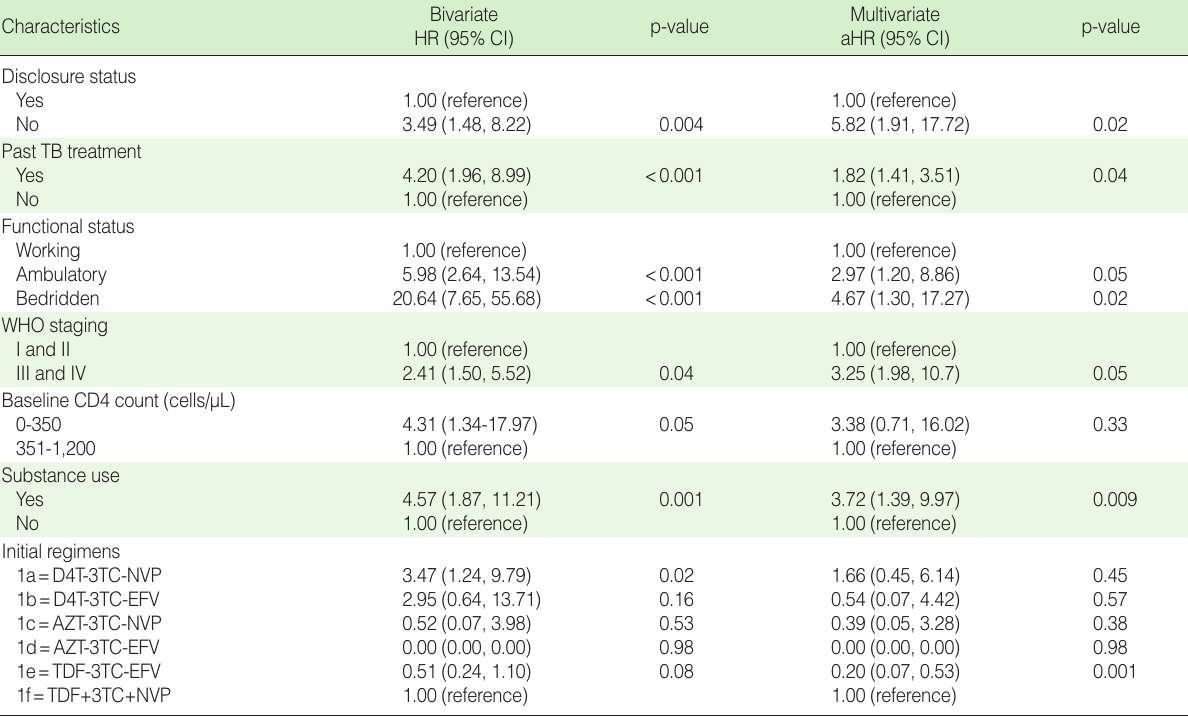
Table 4. Results of the bivariate and multivariate Cox regression analysis of HIV patients receiving antiretroviral treatment, Jinka Hospital, South Omo, Ethiopia in 2016 (n=350) Characteristics